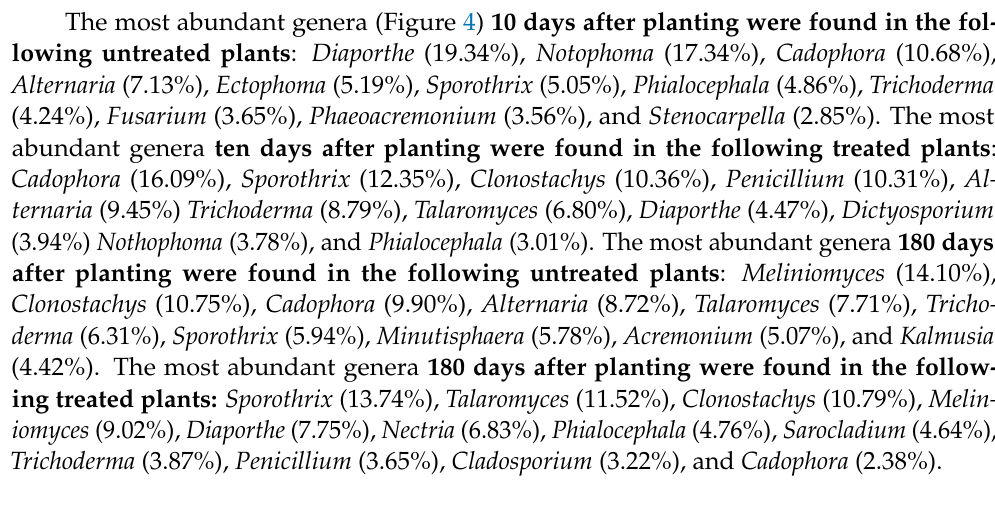
Figure 3. Principal coordinate analysis (PCoA) results based on Bray-Curtis dissimilarity metrics in 2D, showing the distance in the fungal communities among the 2 terms of sampling—10 days and 180 days after treatment.